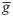
Effects of I
Ca, I
SK and dynamics of intracellular Ca2+ on PN response characteristics.Top panel: effects of the mean maximal conductance g-
SK of I
SK on E1 and I durations (A) and mean firing frequency of E1 and E2 (B). Intermediate panel: effects of the mean maximal conductance g-
Ca of I
Ca on E1 and I duration (C) and mean firing frequency of E1 and E2 (D). Bottom panel: effects of time constant τCa of Ca2+ dynamics on E1 and I duration (E) and mean firing frequency of E1 and E2 phases (F).